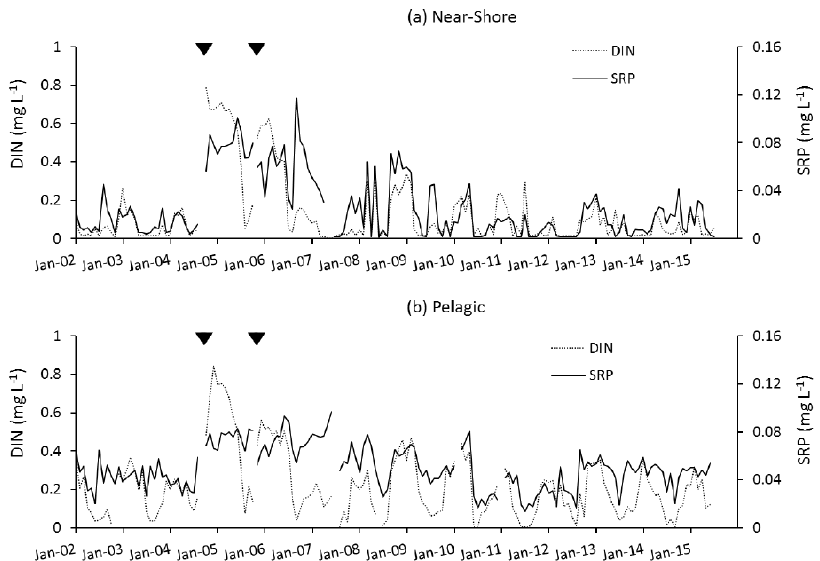
Figure 3. Time series of DIN and SRP concentrations in the near-shore ( a ) and pelagic zones ( b ) of Lake Okeechobee, in the context of impacts of two hurricanes in 2004 and one hurricane in 2005. The two hurricanes in 2004 were so close together in time that they are represented by a single triangle indicating the timing.